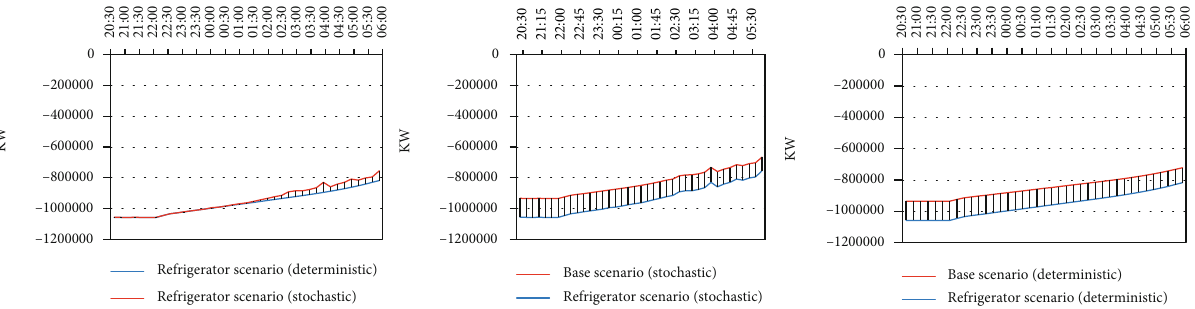
Figure 29: Di ff erent modes in the refrigerator scenario (night).